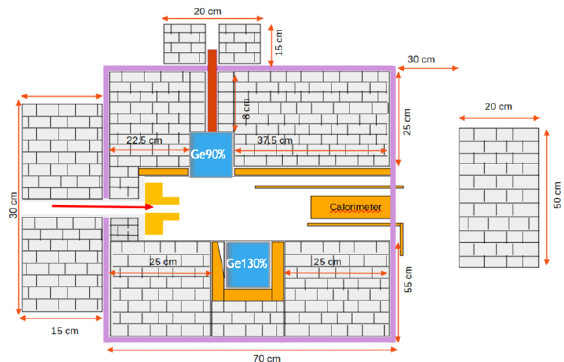
Fig. 3. Experimental setup adopted for the 20 Ne(p, γ ) 21 Na study at